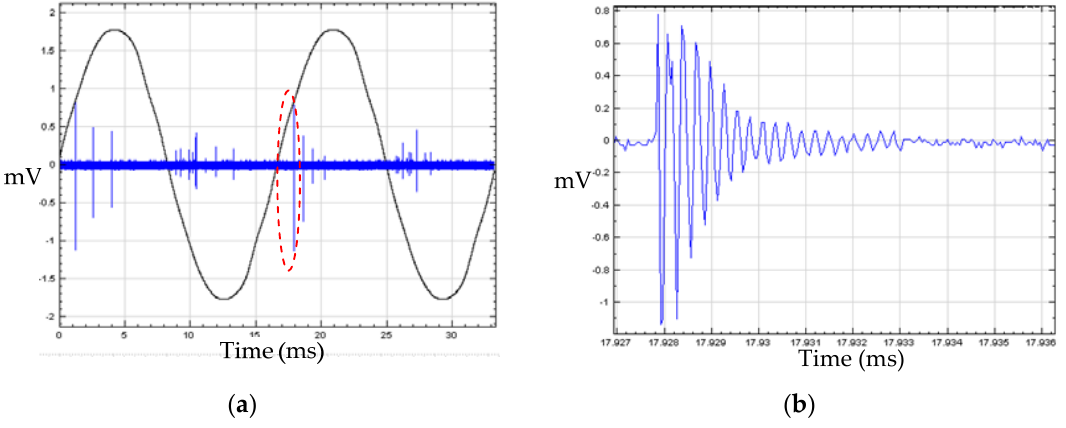
Figure 9. Partial discharge signal. ( a ) PD signal in sin wave. ( b ) One PD pulse.